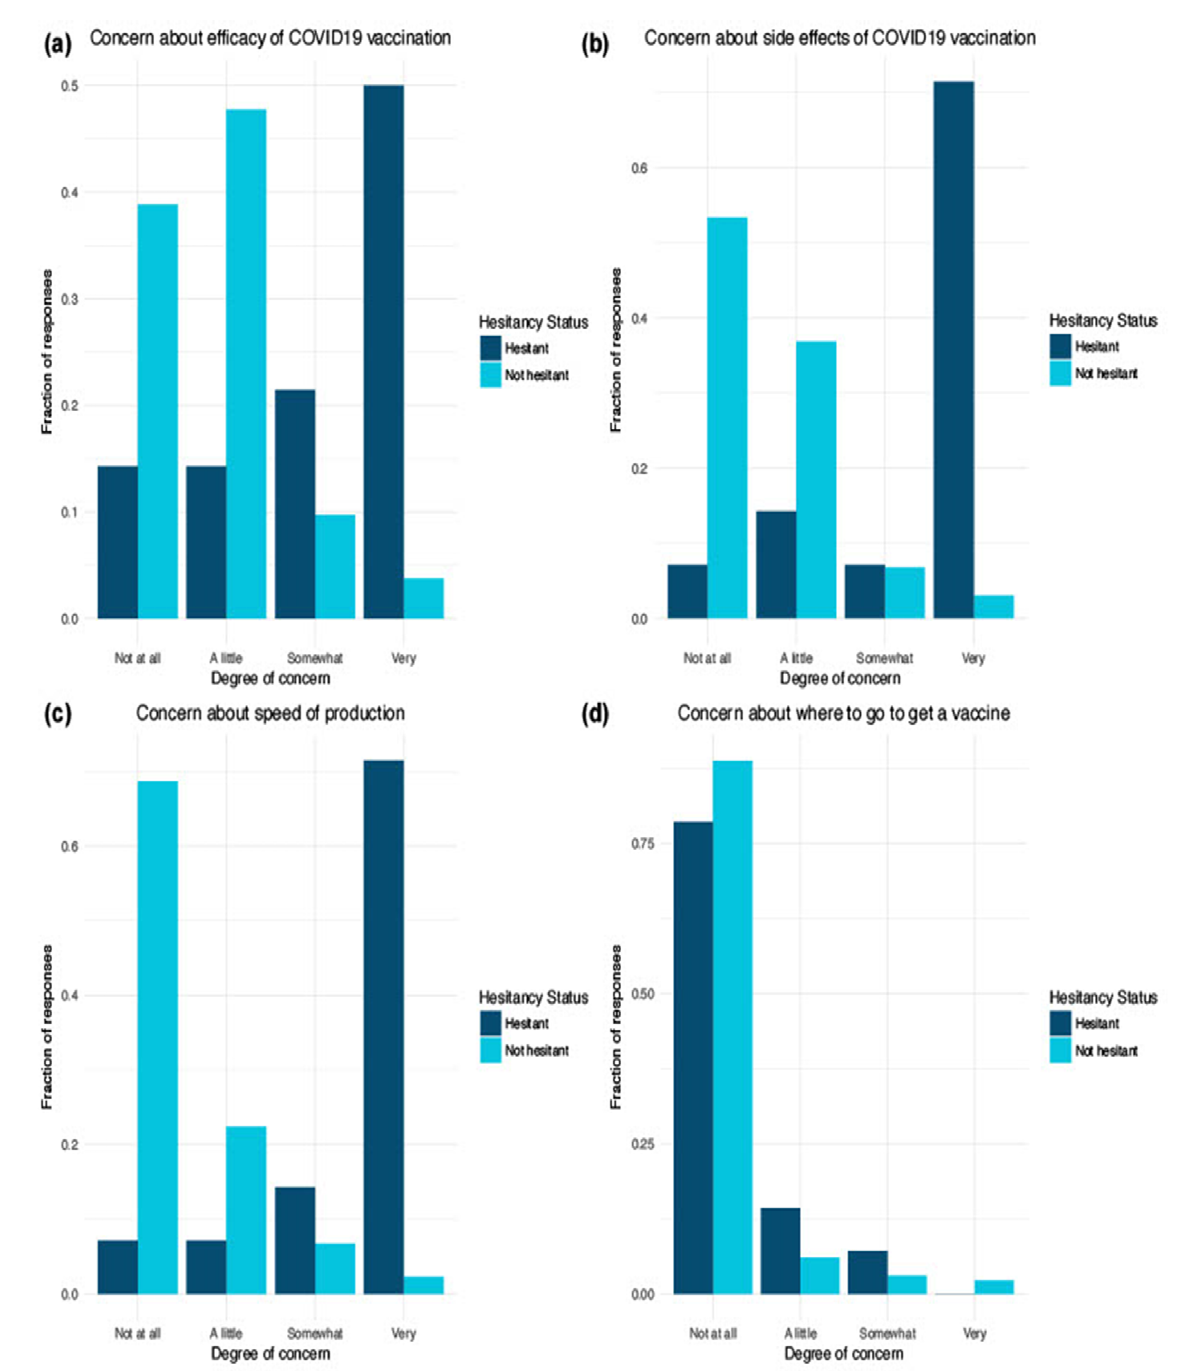
Figure 2. ( a ) Degree of concern between hesitant and not hesitant respondents about efficacy of COVID19 vaccination. ( b ) Degree of concern about side effects of COVID19 vaccination. ( c ) Degree of concern about COVID19 vaccine speed of production. ( d ) Degree of concern about where to get a COVID19 vaccine.